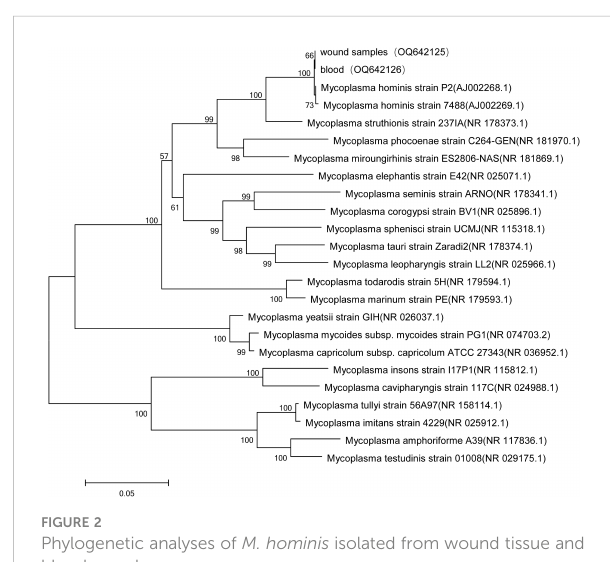
FIGURE 2 Phylogenetic analyses of M. hominis isolated from wound tissue and blood